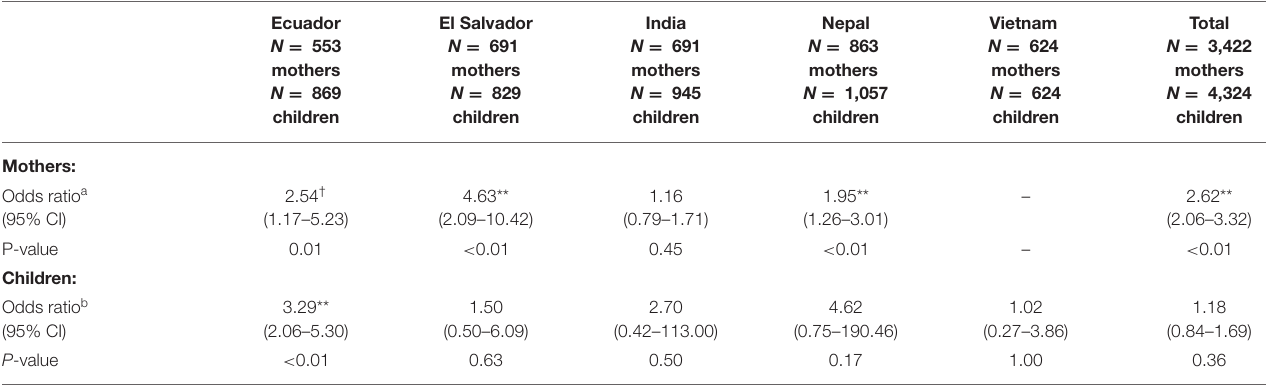
TABLE 4 | Maternal-child access to dental care associated with prenatal care and